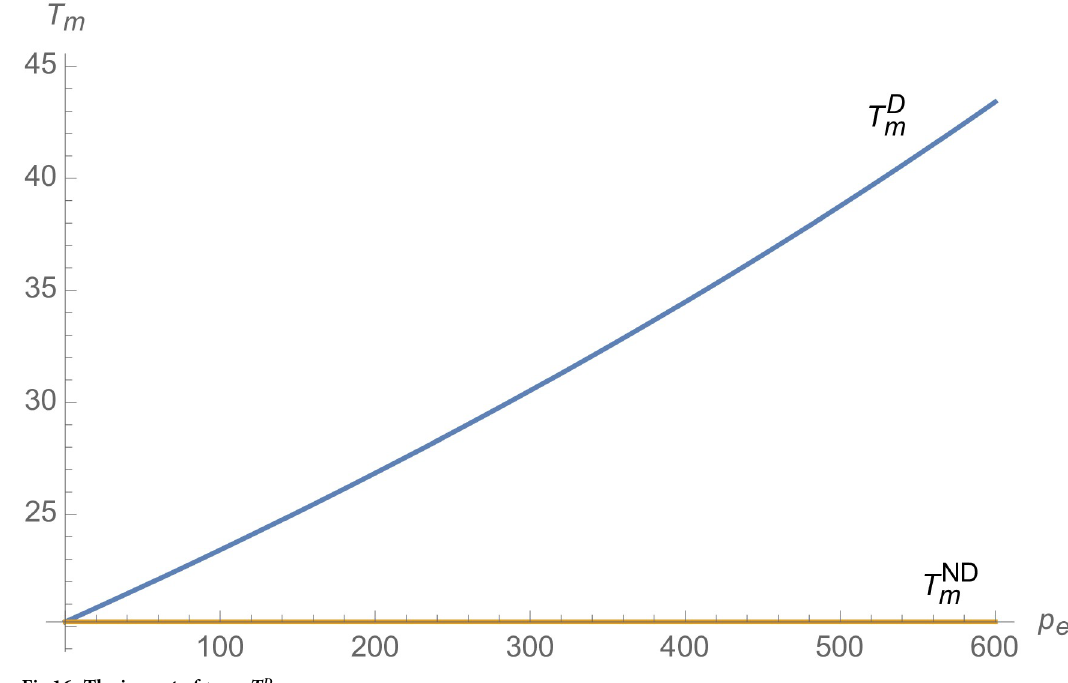
Fig 16. The impact of p e on T D